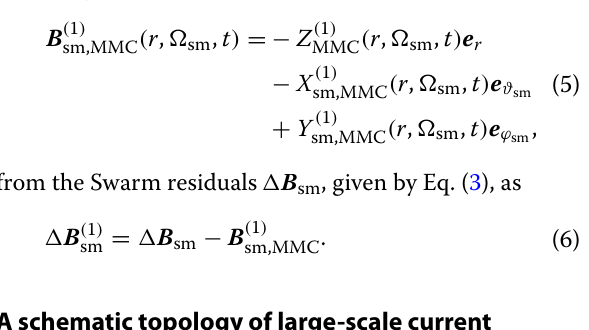
Table 1 Swarm A satellite tracks selected to demonstrate the results for moderately disturbed times Track